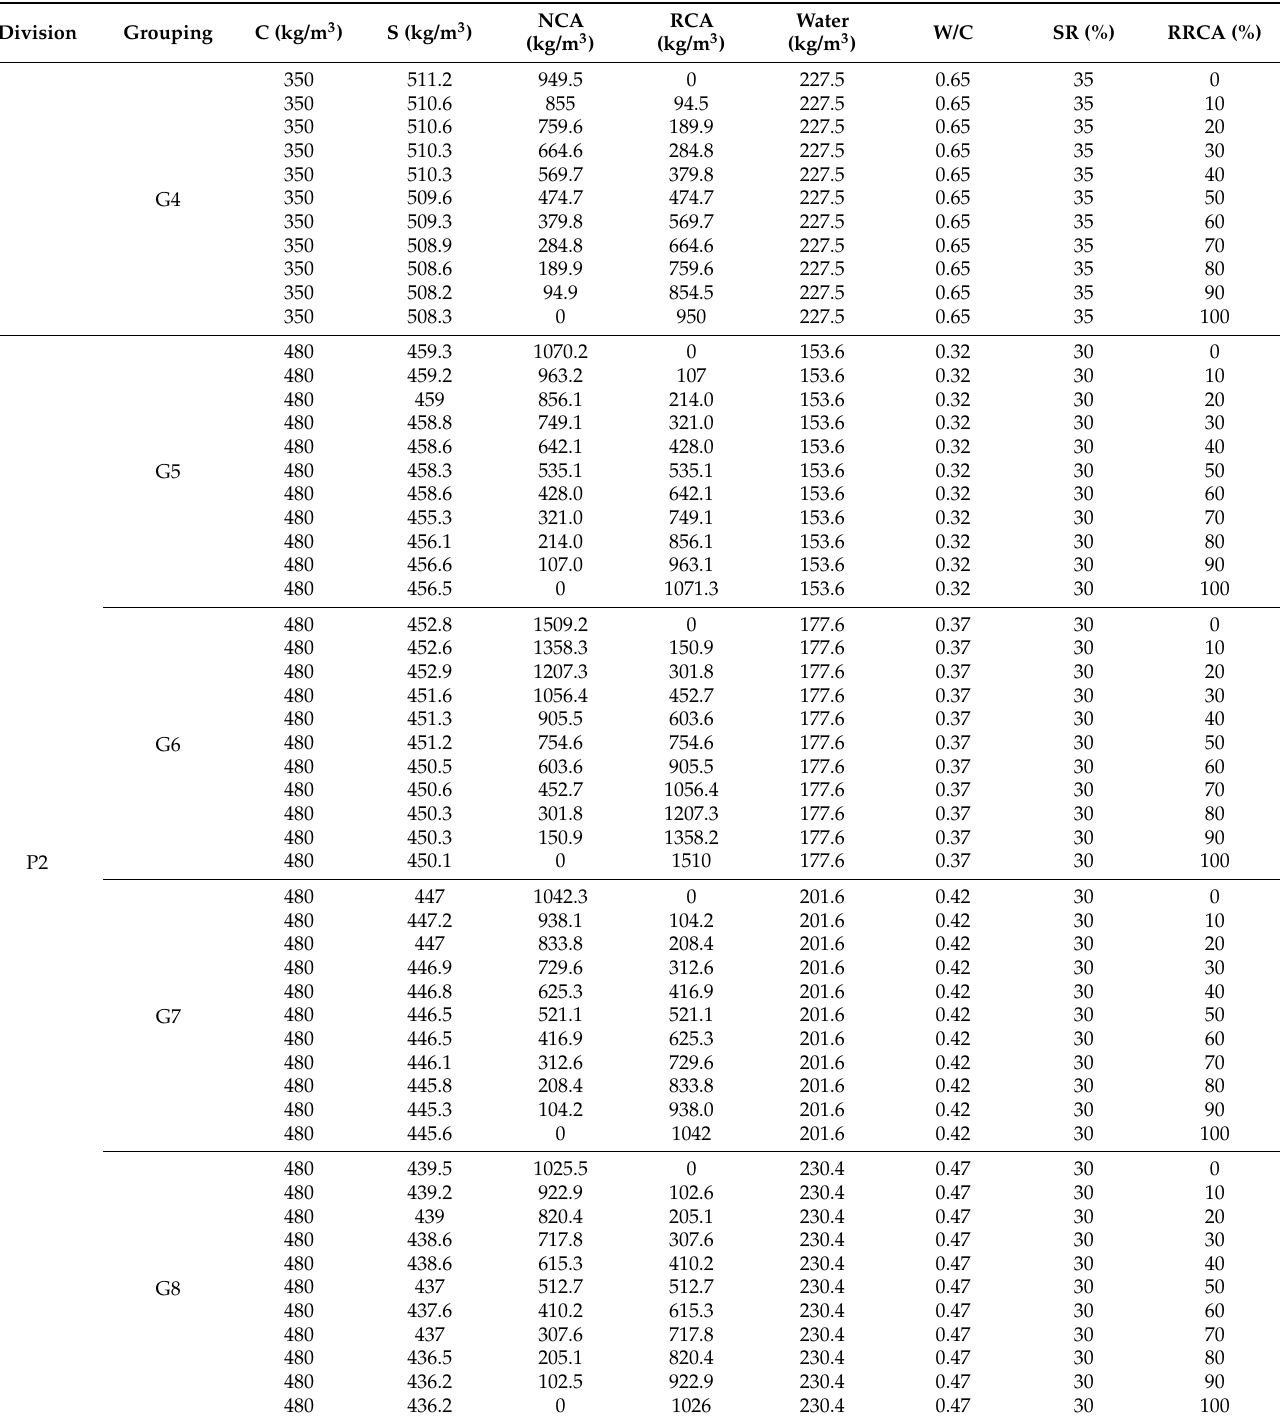
Table 5. Experimental mixing proportion